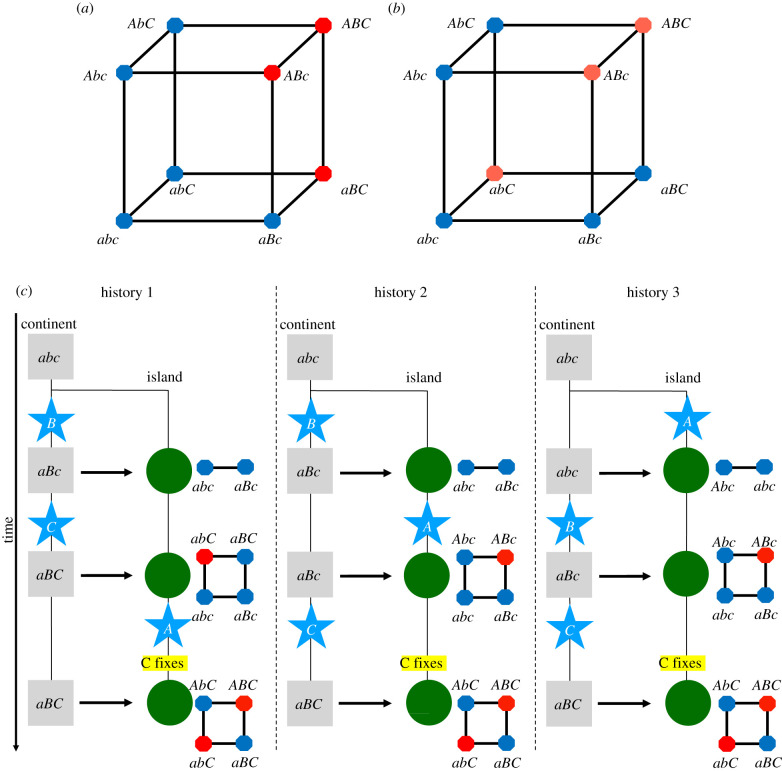
With three loci and cryptic epistasis, the high-fitness ridge of a parapatric two-locus DMI can be turned into a deep fitness valley. (a) Fitness graph for a model with negative pairwise epistasis between A and B, and B and C, which does not allow for parapatric evolution of a strong genetic barrier. Red octagons correspond to low-fitness haplotypes and blue octagons to high-fitness haplotypes. (b) Fitness graph for a model with negative epistasis between A and B and a strongly deleterious allele C. Both alleles A and B can compensate for the deleterious effect of C but the compensation is not cumulative. This fitness landscape can allow for the parapatric evolution of a strong genetic barrier, because it contains a two-locus fitness graph with two fitness peaks isolated from each other by a deep valley, if allele C is fixed. (c) Three possible evolutionary histories and the temporary underlying fitness graphs (subgraphs of (b)) can lead to the formation of a fitness landscape in which the two fitness peaks (AbC and aBC) are separated by an unsurpassable fitness valley. This strong genetic barrier can evolve via single-step mutations in the presence of gene flow, owing to the existence of a high-fitness ridge that disappears through fixation of allele C. (Online version in colour.)